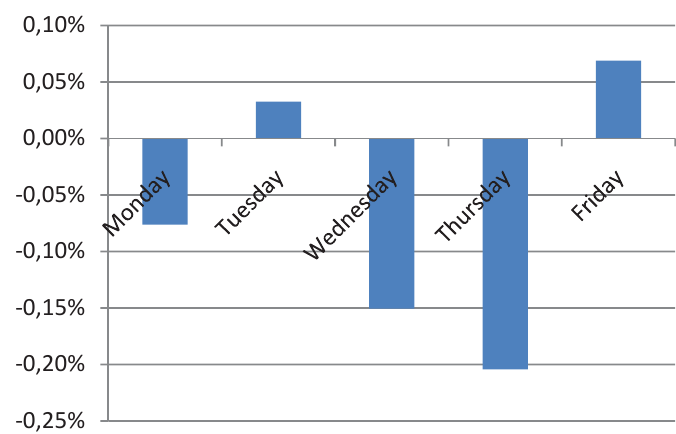
Fig. B3. Average analysis case of UX